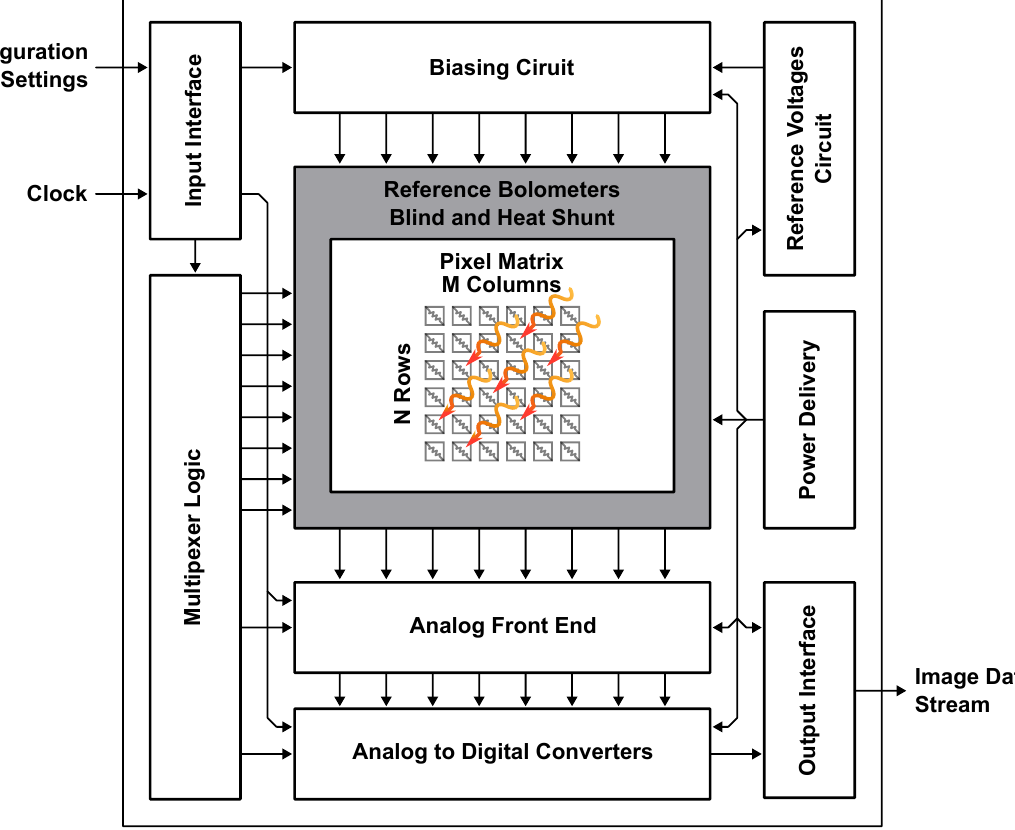
Figure 5. Conceptual block diagram of an IRFPA